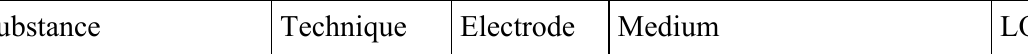
Table 1. Selected examples of recently developed methods of polarographic and voltammetric determination of chemical